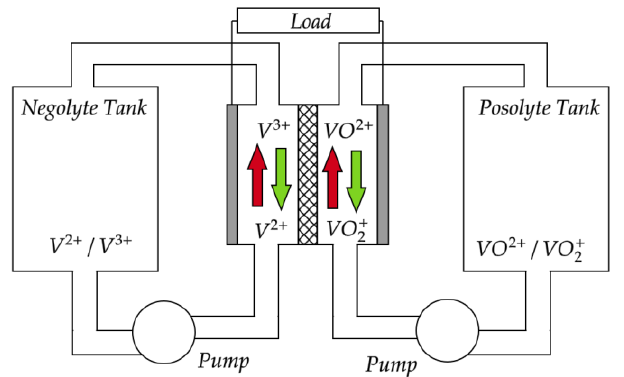
Figure 1. Schematic of vanadium redox flow battery (green is charge and red is discharge).